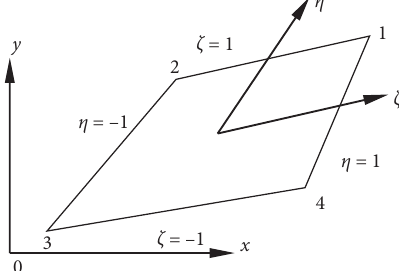
Figure 2: Diagram of coordinate transformation for a 4-node quadrilateral isoparametric